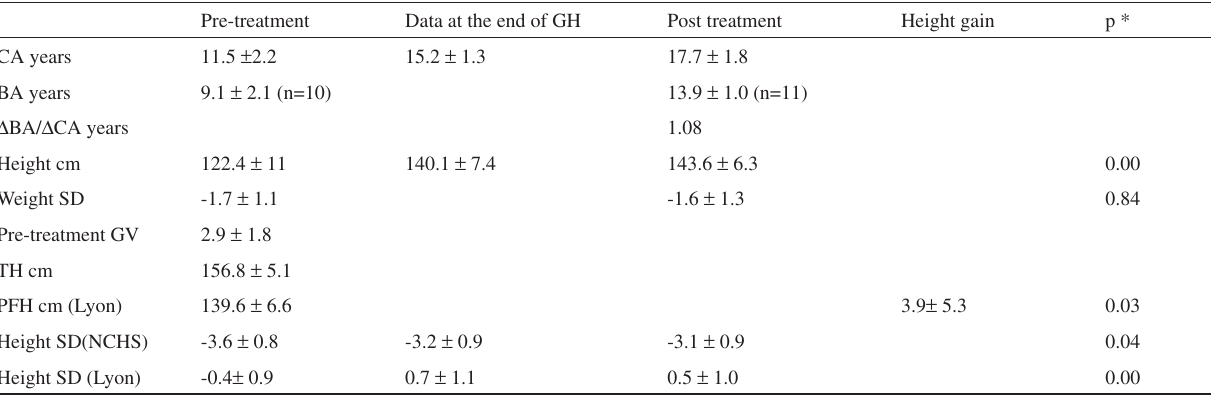
Table 3 - Characteristics of 11 TS patients who reached final height (Mean (cid:111) SD)